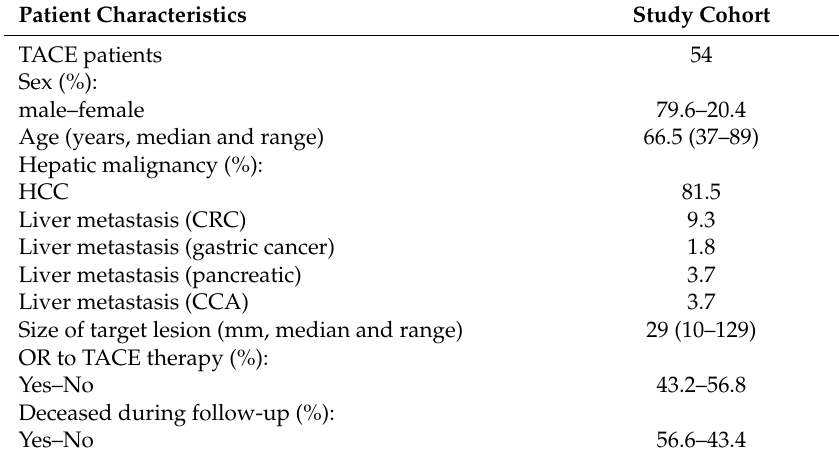
Table 3. Characteristics of study